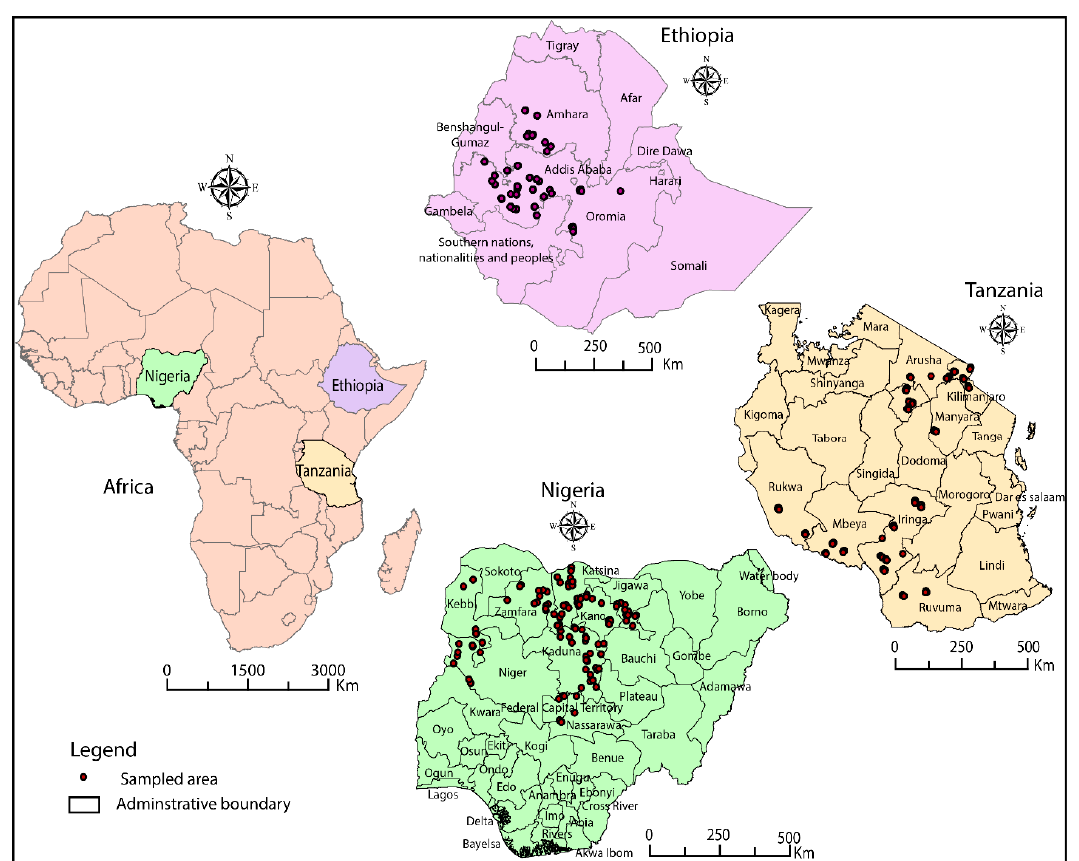
Figure 1. The location of the three countries in Africa and the relative locations of the maize trial sites used in this study.